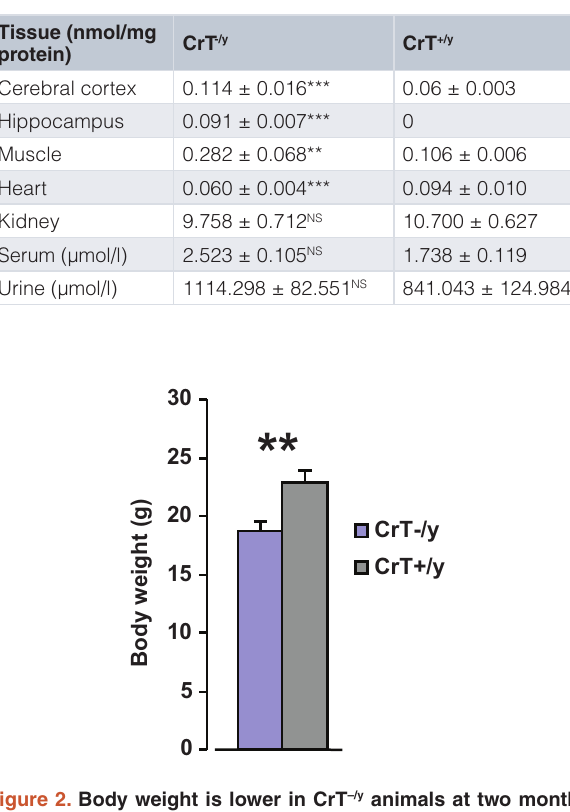
Table 2. GAA levels in CrT –/y mutant and WT mice. GAA levels (mean ± SEM) in CrT –/y and CrT +/y animals (n = 4 per tissue for both groups, except n = 5 for urine measurement in CrT −/y mice). An increase of GAA levels was present in the brain, muscle and heart of mutant animals, while no difference was detected in kidney, serum and urine (Two Way ANOVA on rank transformed data, post hoc Holm-Sidak method). * p < 0.05; ** p < 0.01; *** p < 0.001.